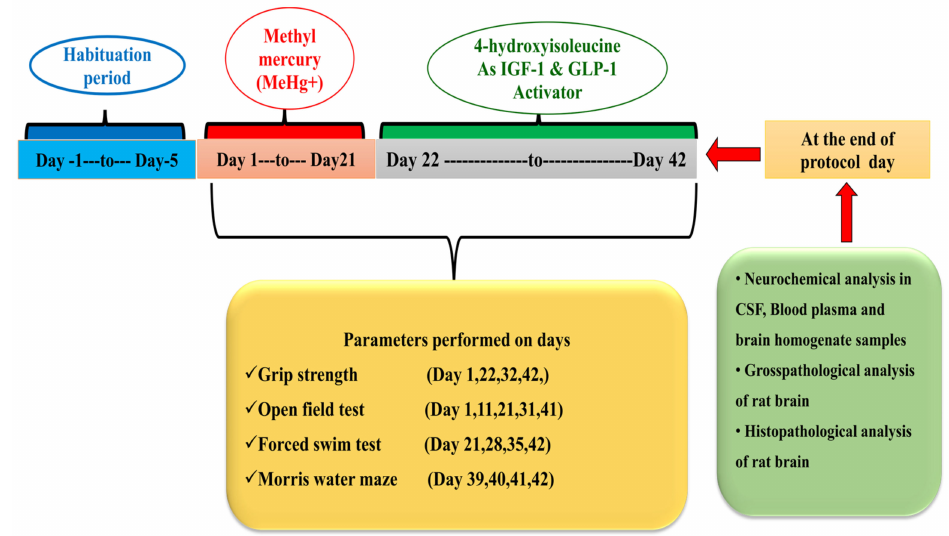
Figure 1. Experimental protocol